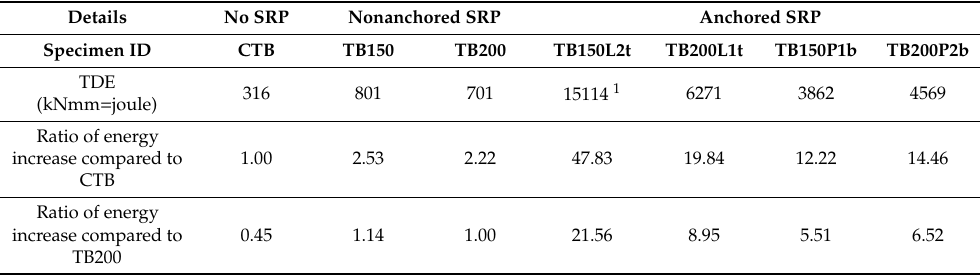
Table 5. Total dissipated